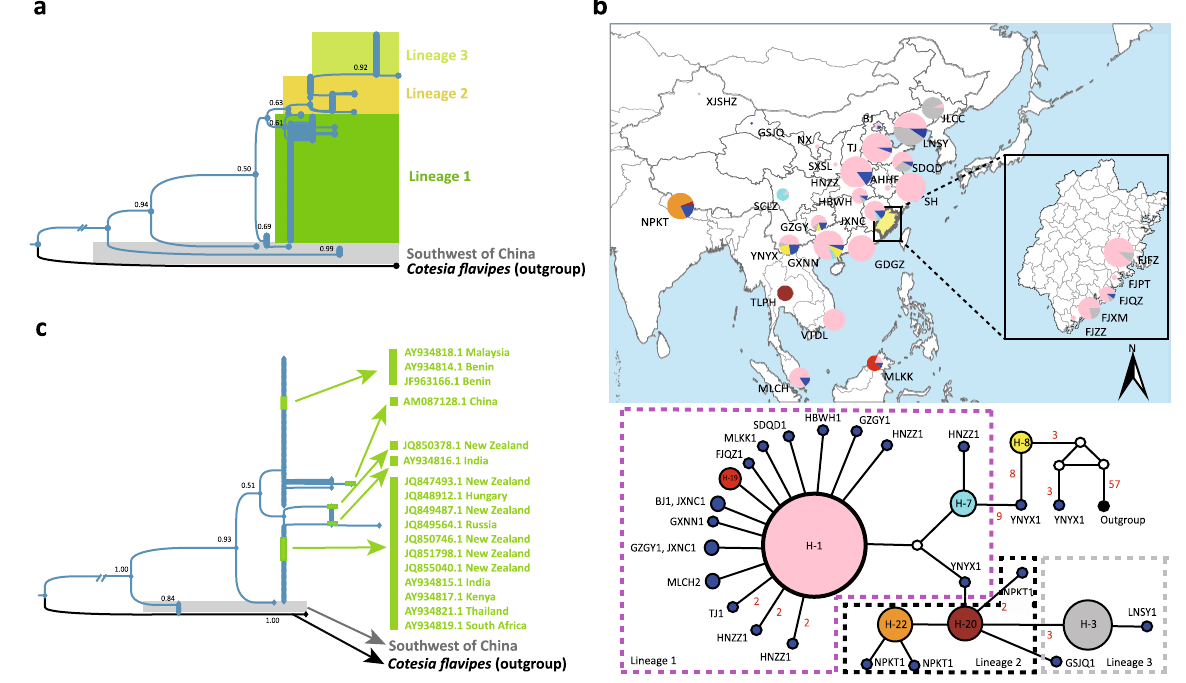
Figure 2. Phylogenetic Tree and Haplotype Network of Cotesia vestalis . ( a ) Phylogeny of C. vestalis based on the concatenated CoxI , Cytb and NadhI genes using maximum likelihood algorithm with 1000 bootstraps, with C. flavipes as an outgroup. ( b ) Haplotype network based on three concatenated genes, CoxI , Cytb and NadhI for C. vestalis . The number of mutations > 1 is presented beside the corresponding branches; haplotypes with frequency ≤ 4 are illustrated in blue and labeled with sampling location acronyms and numbers; small empty circles represent unsampled haplotypes; haplotypes labeled YNYX are from Southwest China. ( c ) Phylogeny of global C. vestalis samples based on the CoxI gene (545 bp) using maximum likelihood algorithm with 1000 bootstraps, with C. flavipes as an outgroup. Individuals in green indicate recruited individuals from Europe, Africa, Oceania and Asia. Numbers upon branches are bootstrap values >